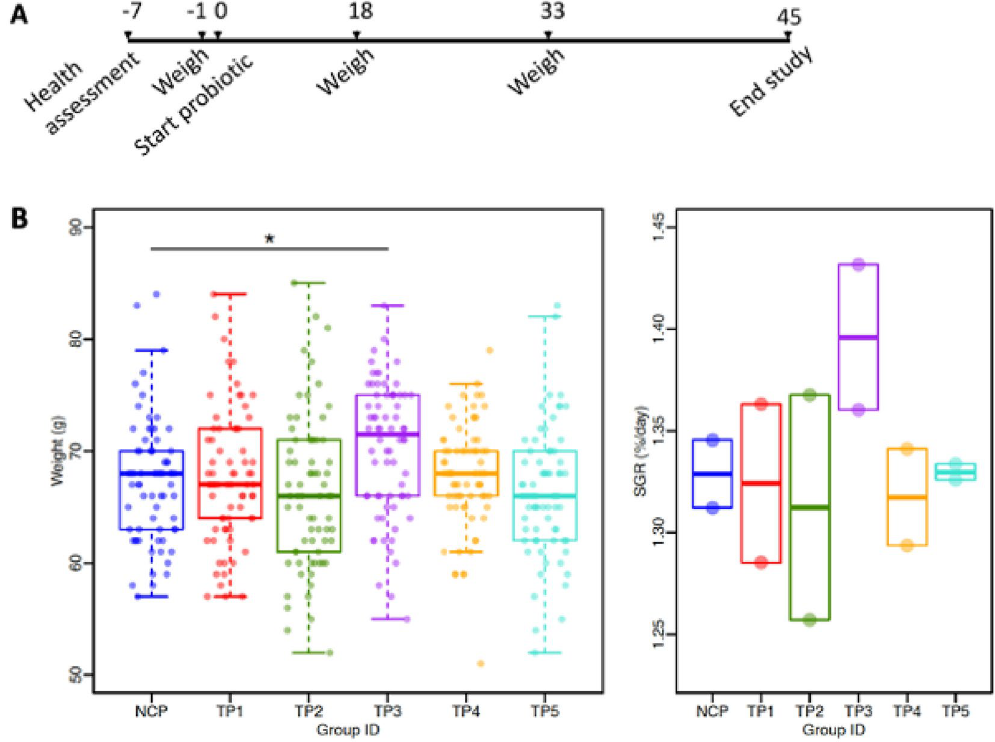
Figure 3. Effect of probiotic supplementation on the weights of salmon following daily administration in feed for 45 days in freshwater. ( A ) Timeline of experimental events. ( B ) Body weights and specific growth rates (SGR, %/day) for each group following daily administration of the respective probiotic candidates in feed for 45 days. Horizontal bar denotes mean. *P = 0.0172 for NCP vs TP3, ANOVA with Dunnett’s test (n = 70). TP, Test Product; NCP, negative control